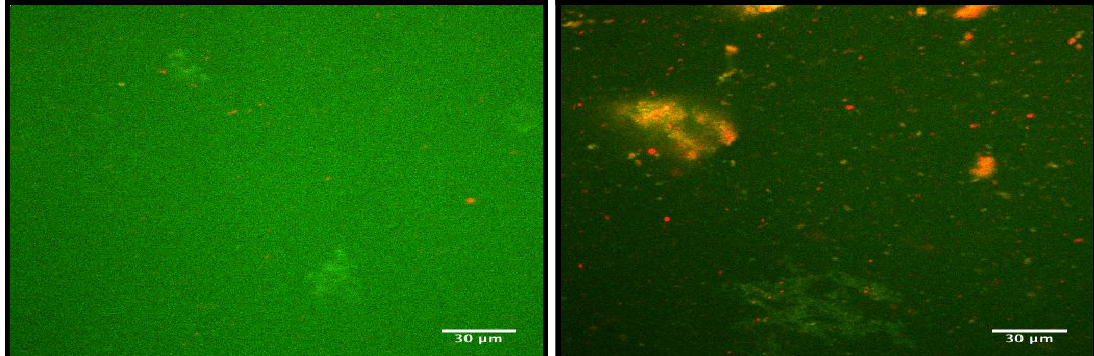
Figure 3. Images of control (enriched with powdered skim milk) skim milk (left) and skim milk + WBAP aggregates (0.6 g/100 mL; right) at pH 6.8, using the Nikon C1 confocal laser scanning microscope at 60×; proteins are dyed green and phospholipids are